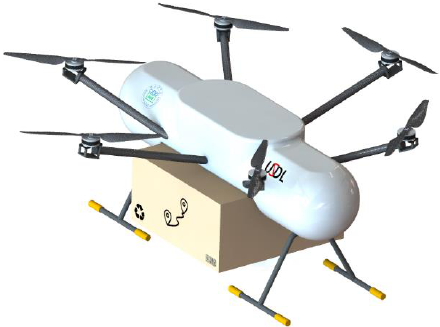
Figure 6. Preliminary design of urban package delivery drone developed by a PNU drone.